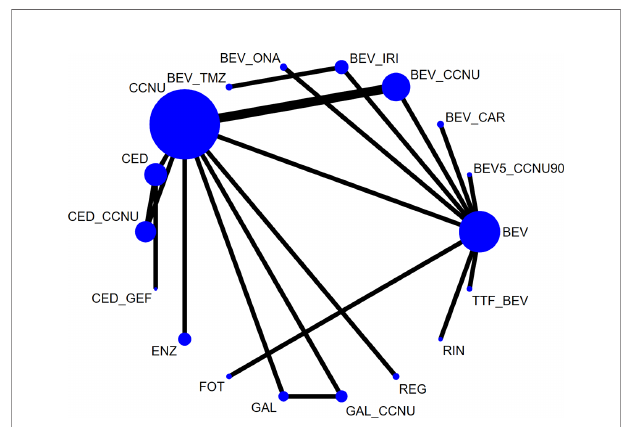
FIGURE 2 | Network plot of all eligible comparisons involved. The size of every solid circle is proportional to the total sample size, and the width of the line is proportional to the number of clinical trials. Network plots of each outcome are shown in Supplementary Figures . BEV, bevacizumab monotherapy or combined with placebo; CCNU, lomustine monotherapy or plus placebo; TMZ, temozolomide; BEV_CCNU, bevacizumab plus lomustine; BV5_CCNU90, low-dose bevacizumab (5 mg/kg) plus low-dose lomustine (90 mg/m 2 ); BEV_TMZ, bevacizumab plus temozolomide; BEV_ONA, bevacizumab plus onartuzumab; BEV_IRV, bevacizumab plus irinotecan; BEV_CAR, bevacizumab plus carboplatin; GAL, galunisertib;